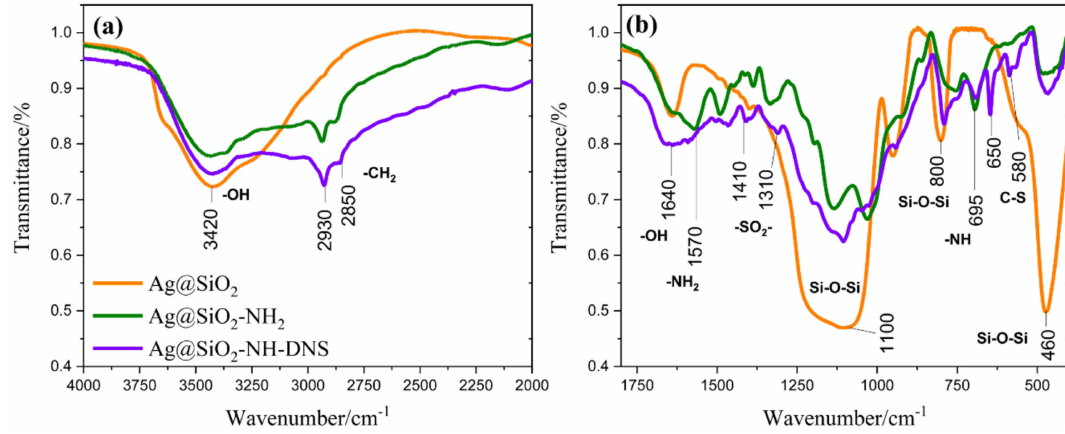
Figure 2. FT-IR spectra in range ( a ) 4000 to 2000 cm − 1 and ( b ) 1800 to 400 cm − 1 for Ag@SiO 2 , Ag@SiO 2 -NH 2 , and Ag@SiO 2 -NH-DNS.